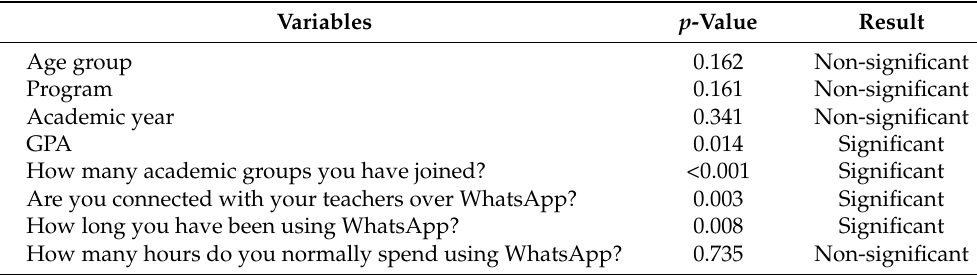
Table 7. Crosstabulated results of WhatsApp usage during academic activity with several variables of the Indian